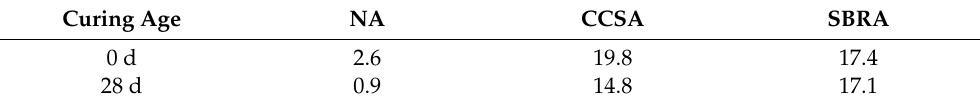
Figure 7. Self-shrinkage rate of concretes. ( a ) The specimens of concrete self-shrinkage; ( b ) Self- shrinkage rate of concretes. Table 7. Water content of synthesized biomass recycled